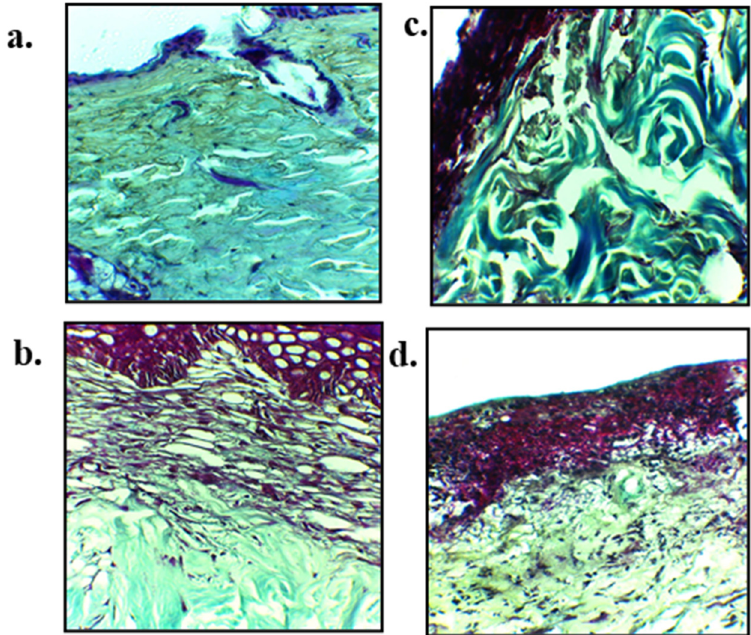
Figure 11. Masson trichrome staining of skin samples extracted on day 14 of wounding on ( a ) untreated, ( b ) blend film, ( c ) nanoparticles and ( d ) nanoparticles-blend film combined treated skin samples.